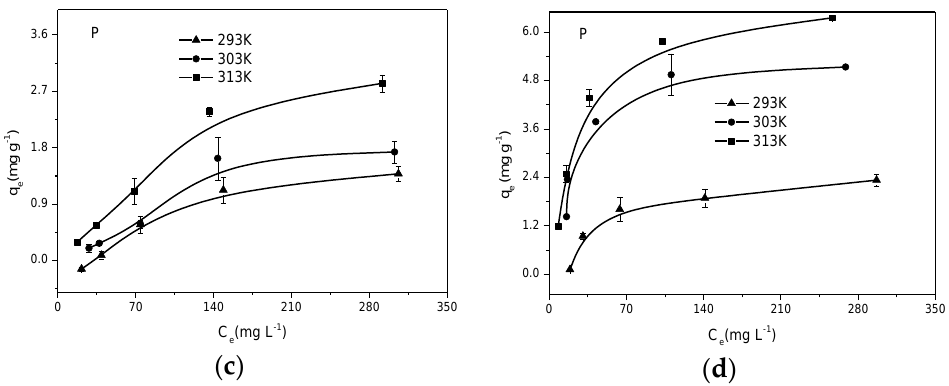
Figure 4. Amount of P on RSB700 ( a ), PCB300 ( b ), SDB300 ( c ) and ESB700 ( d ) under different temperature. Data are means ± SD of n = 3.